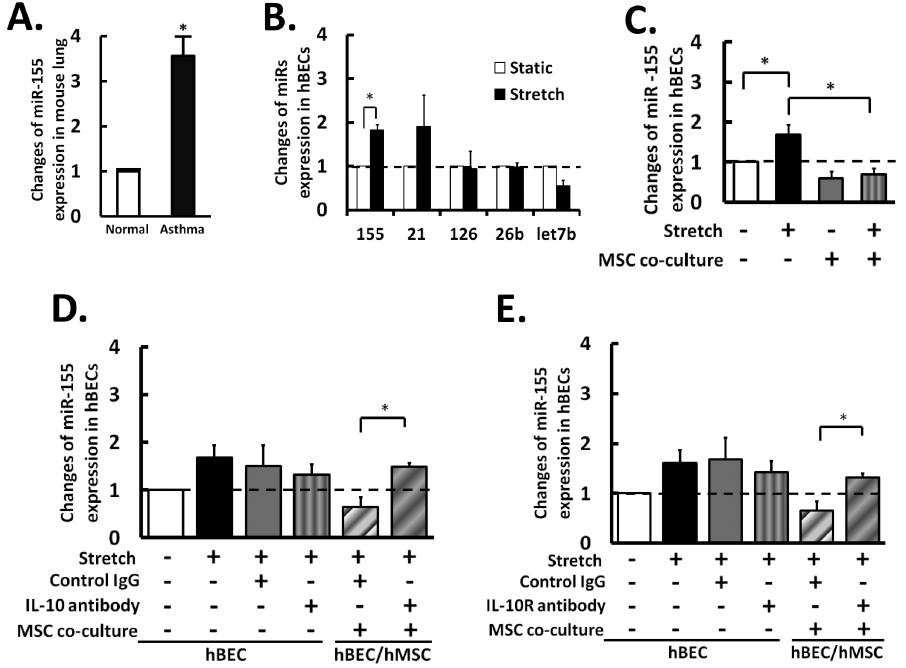
Figure 4. The miRs expression in cells under inflammatory challenages. (A) The expression of miR-155 in asthmatic and normal lung tissues of mice. (B) Examination of hyperstretch-regulated miRs, where miR-155 was significantly increased. (C) Hyperstretch regulation of miR-155 in hBECs with or without hMSCs co-culture. Expression levels of hBEC miR-155 in mono-culture (first four bars), and in co-culture (5 th and 6 th bar) after treatments with (D) IL-10 antibodies, and (E) IL-10 receptor [IL-10R] blocking antibodies. The results demonstrated that hMSCs and IL-10 had similar effects on up-regulation of hyperstretch-induction miR-155 expression in hBEC. The changes in secretion level are relative to static control. Data represent mean 6 s.e.m. *, P , 0.05; **, P , 0.01 n=5.